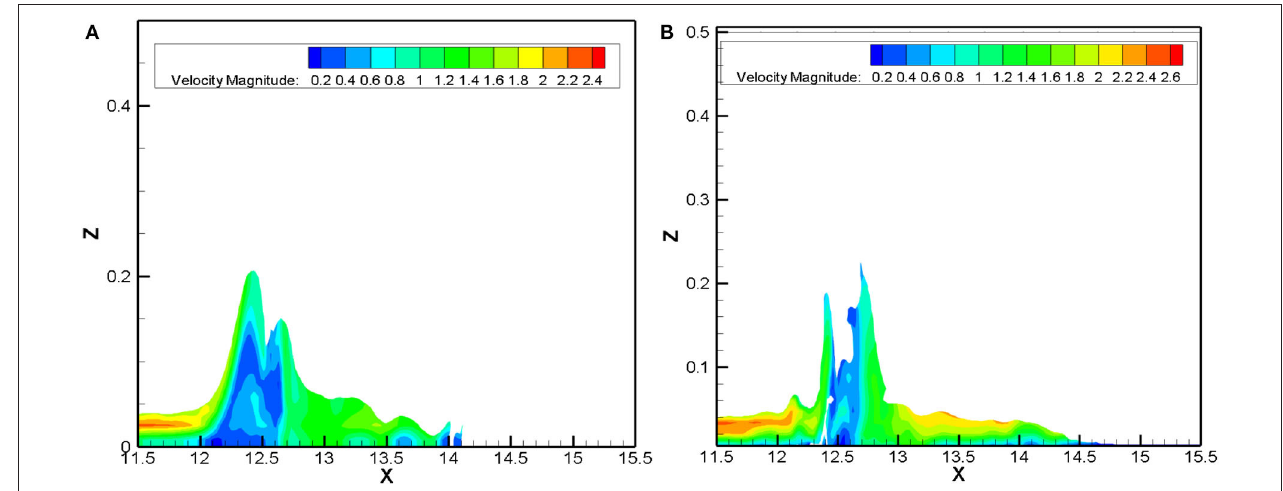
z plane. (A) t 4.0s (CLSVOF/IB method); (B) t − =